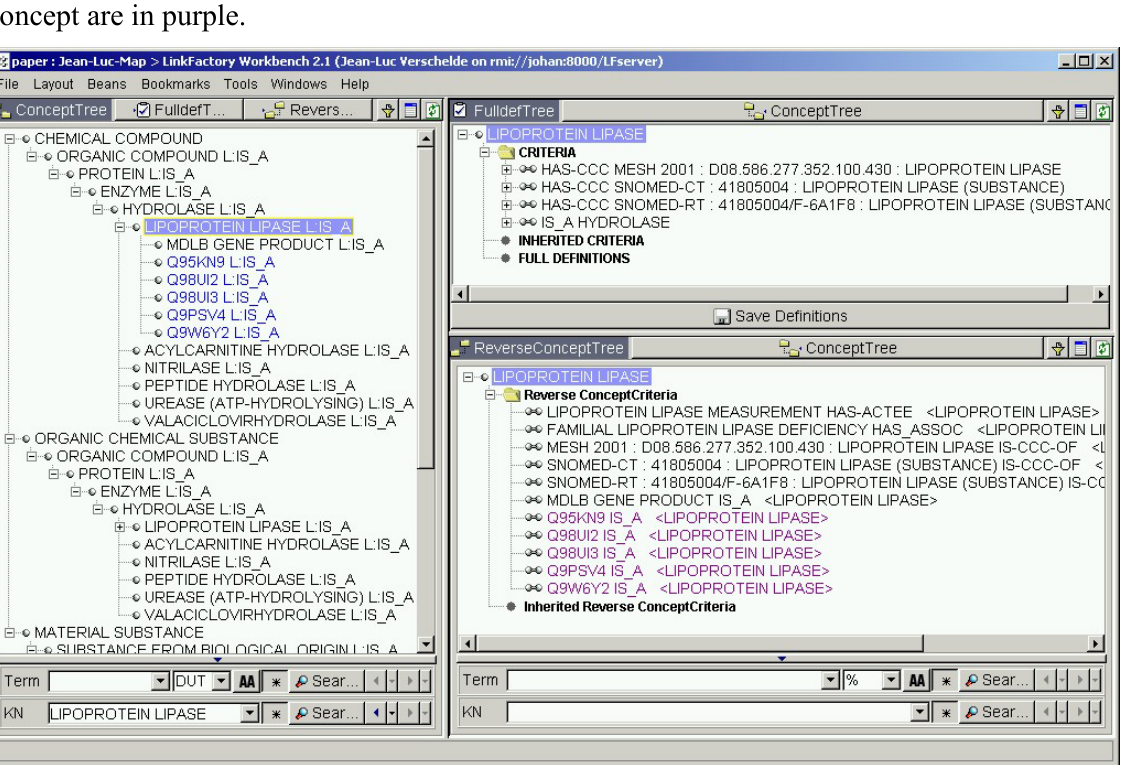
Figure 2 An example of mapping the database "Protein name" entry 'lipoprotein lipase' on its LinKBase® equivalent on row